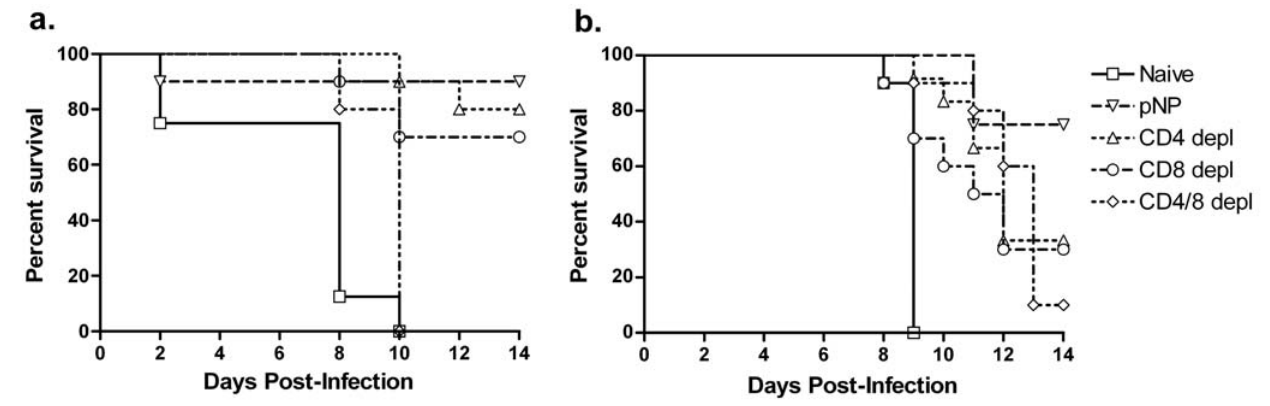
Figure 3. Kaplan-Meier survival curve in mice challenged with (a) H1N1 influenza (A/PR/8/34) and (b) H5N1 influenza (A/Vietnam/ 1203/04). All mice were immunized with pNP (except for naı¨ve) and depleted of CD4 + T cells, CD8 + T cells, both, or neither.